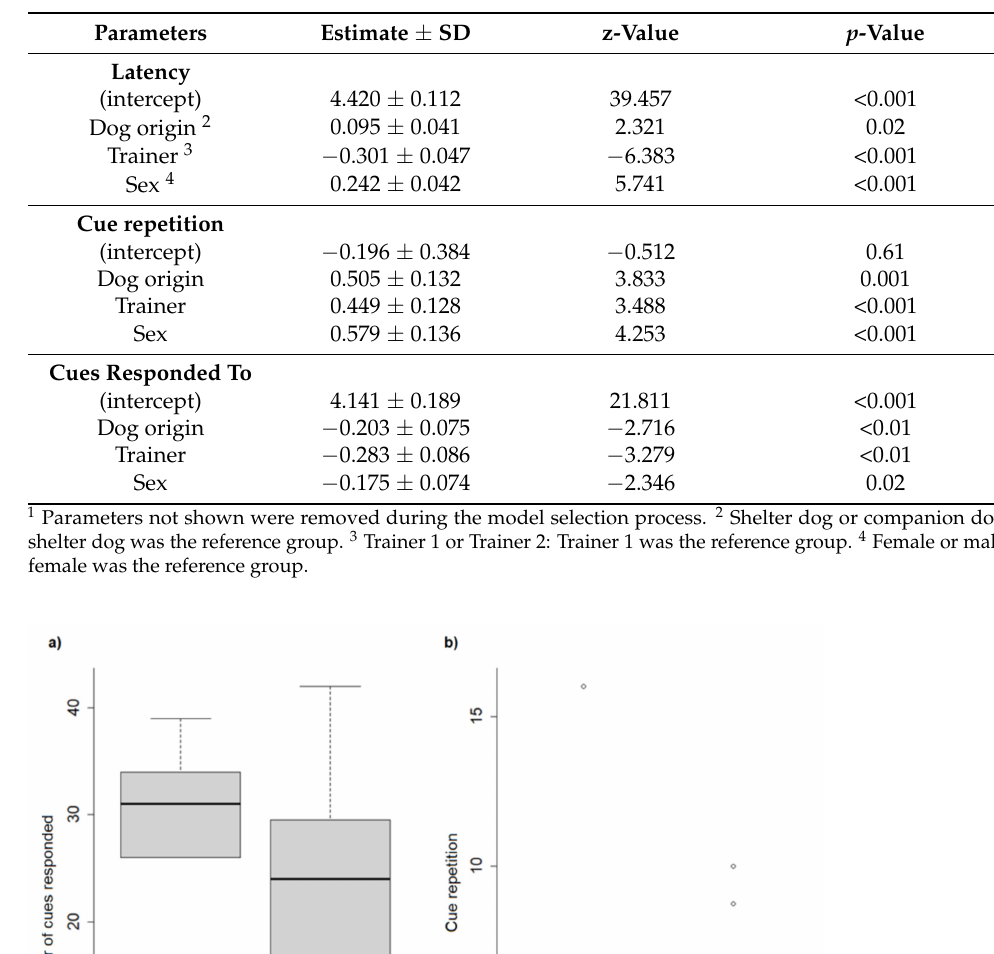
Table 4. Final reduced models (GLM1) of the effects of dog origin, sex, and trainer identity on latency to respond to the cues, cue repetition, and number of cues responded to (in the last training session of each dog); the number of sessions required to learn both commands; the number of sessions required to learn “sit”; the number of sessions required to learn “paw”; and the number of dogs that reached the learning criterion, as recorded during the training sessions of shelter and companion dogs 1 .